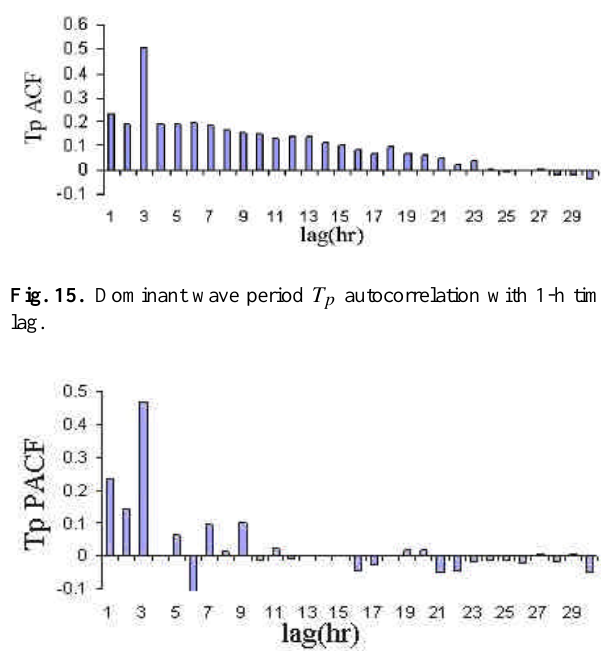
Figure16. Dominant wave period Tp partial auto correlation with 1hr time lag Figure14. Predicted (solid line) and measured (dotted line) significant wave height